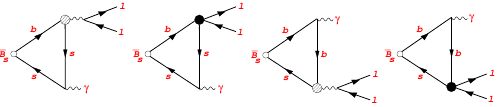
Figure 2. Diagrams, contributing to the ¯ B γ l + l − decays. E ff ective vertices (black s → and dashed circles) correspond to loops with t-quarks and other heavy particles of the SM, which are integrated